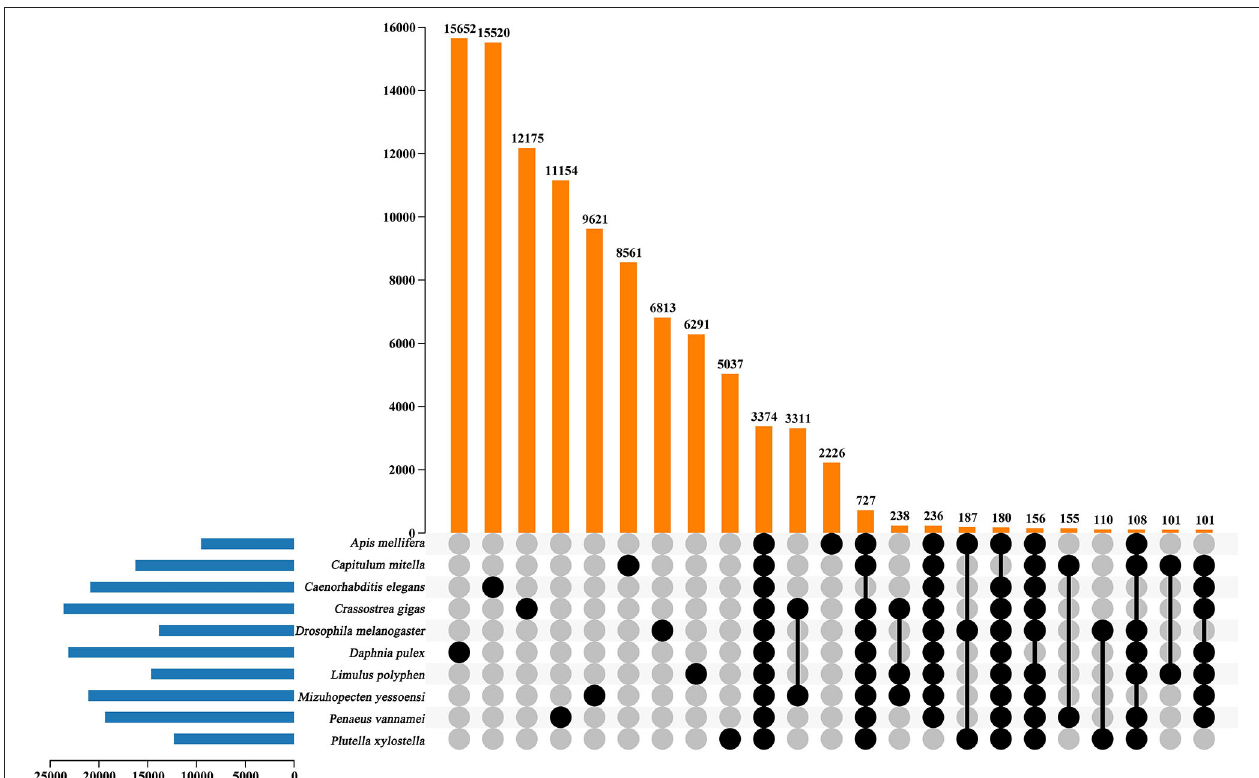
FIGURE 4 | UpSet plot of the intersection of gene families in A. mellifera, C.mitella, C. elegans, C. gigas, D.melanogaster, D. pulex, M. yessoenisis, L. polyphemus, P. vannamei and P. xylostella . The numbers of gene families (clusters) are indicated for each species and species